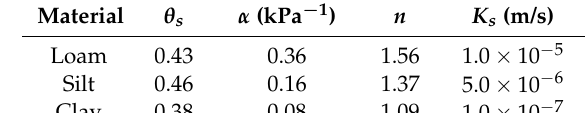
Figure 2. Illustration of slope model. Table 1. Hydraulic properties of slope material [50].